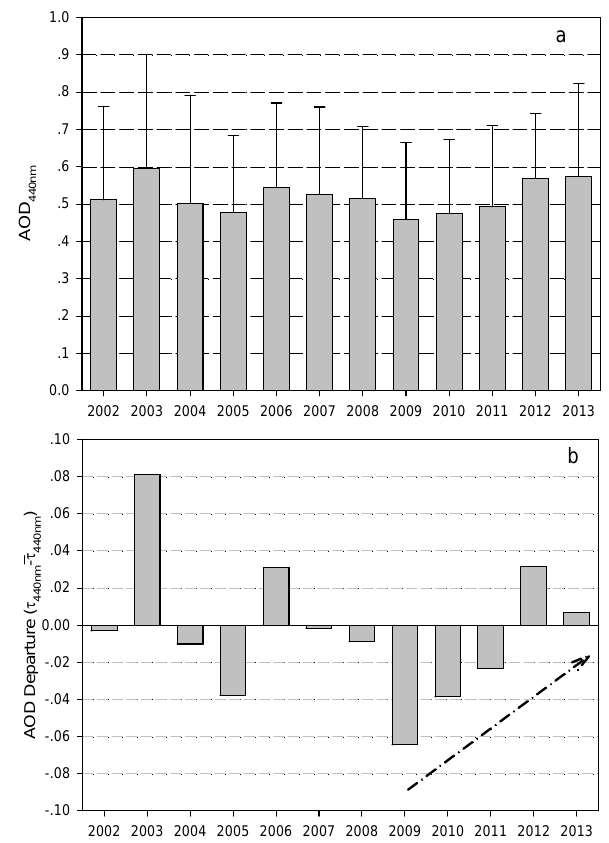
Figure 17. Temporal variations of AODs at 440nm from 2002 to 2013 based on 12 long-term